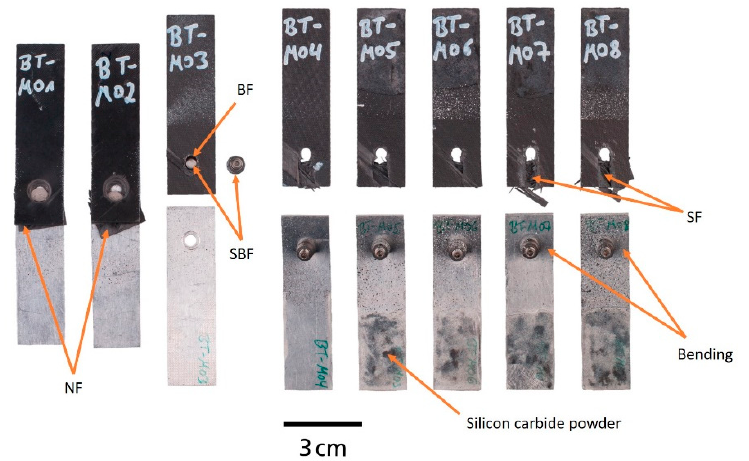
Figure 10. Multi-material bolted joints after testing (BF—bearing failure, SF—shear-out failure, NF—net tension failure, and SBF—bolt shear failure).